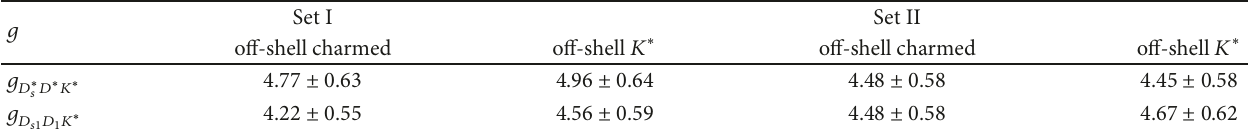
Table 2: The coupling constant of the vertices 𝐷 ∗ 푠 𝐷 ∗ 𝐾 ∗ and 𝐷 푠1 𝐷 1 𝐾 ∗ . 𝑔 Set I Set II off-shell 𝐾 ∗